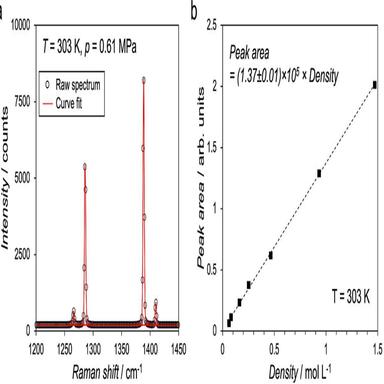
(a) Raman spectrum of carbon dioxide gas (0.61 MPa). (b) Correlation between the total area of the two major carbon dioxide peaks and molar density at constant temperature and measurement conditions (see text).